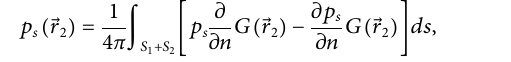
FIGURE 3 (A) Geometric description of axisymmetric hull. (B) Original